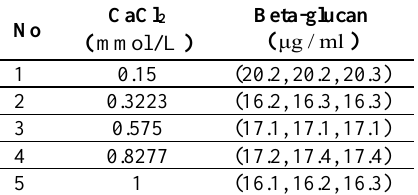
Table 7. Fuzzy data set for CaCl 2 and BG.